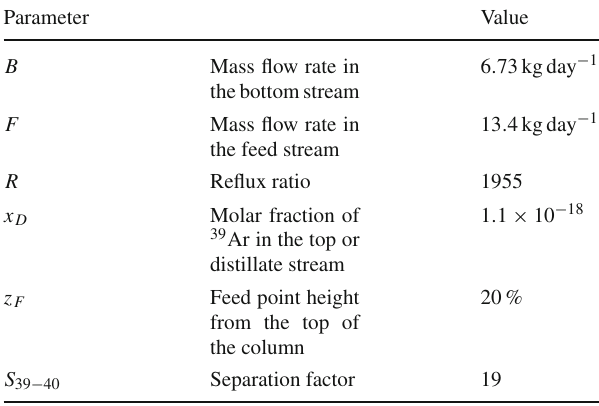
Table 4 Systematic uncertainties on the mass flowrates in the bottom stream, B ,inthecalculationof 39 Ar– 40 ArdistillationwiththeMcCabe– Thiele method, for B / F = 50%. Input parameters are in Table 2